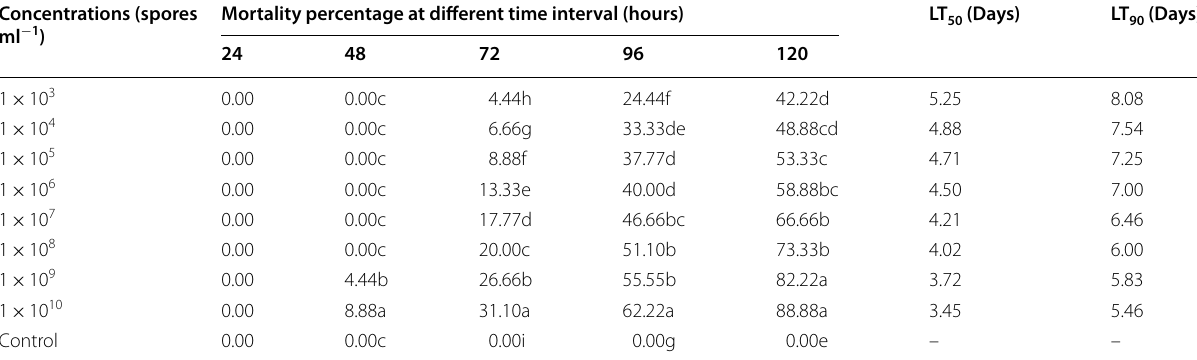
Number denoted by same letter within the column is statistically non-significant (Tukey’s test, p < 0.05); data show the mean of three